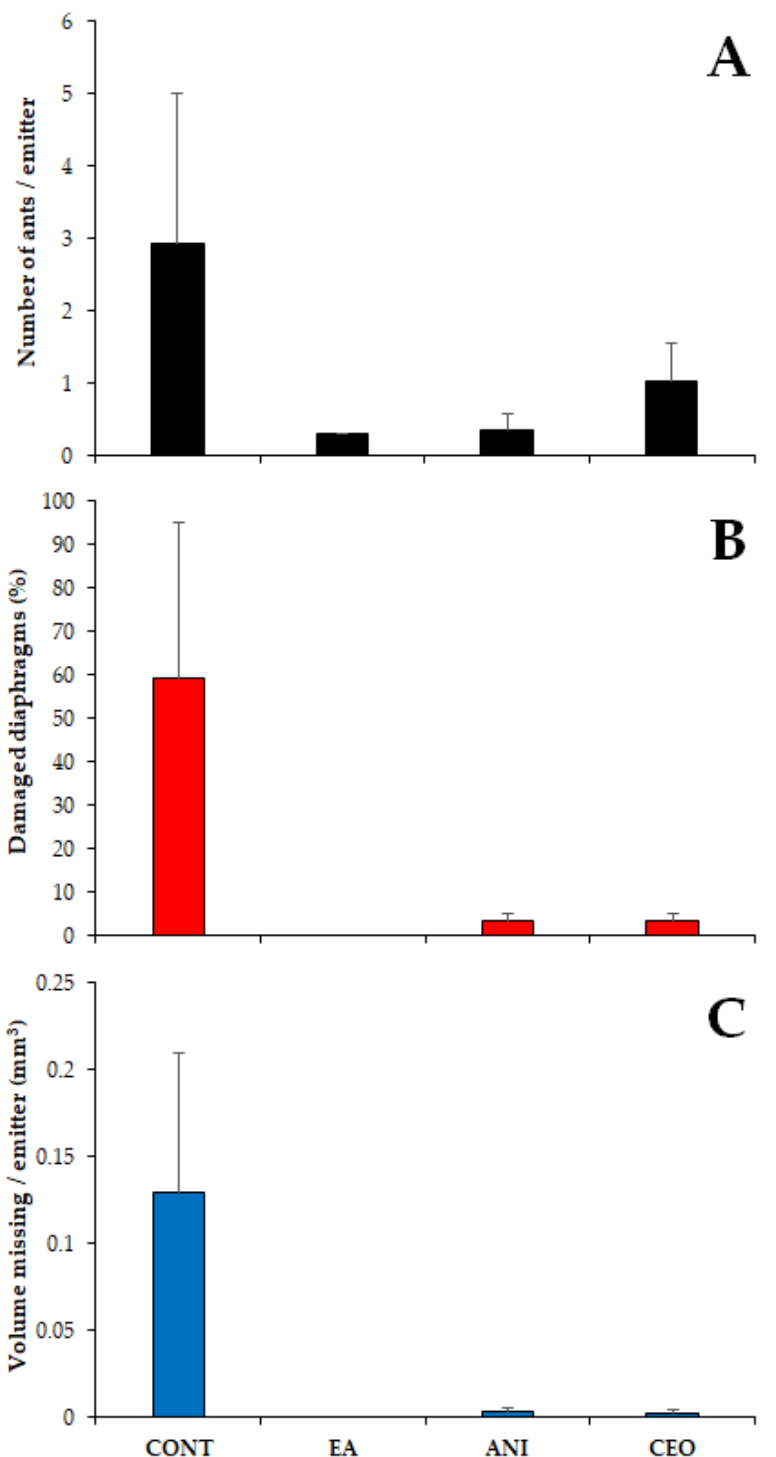
Figure 8. Number of ants ( A ), percentage of emitters showing diaphragm damage ( B ) and volume of diaphragm eroded ( C ) (mean ± SE) observed in the different treatments. CONT: control. EA: ethyl anthranilate. ANI: p-anisaldehyde. CEO: cinnamon essential oil.